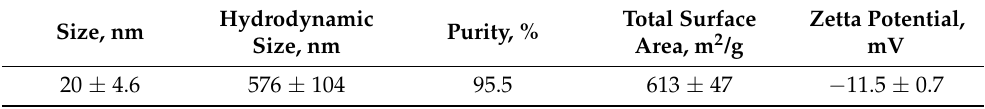
Table 1. The basic properties of SiO 2 NPs. Size,